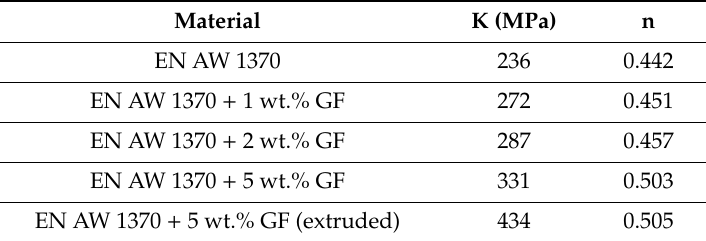
Table 2. Strain-hardening coefficients of the tested samples derived from compression true stress– true strain curves.